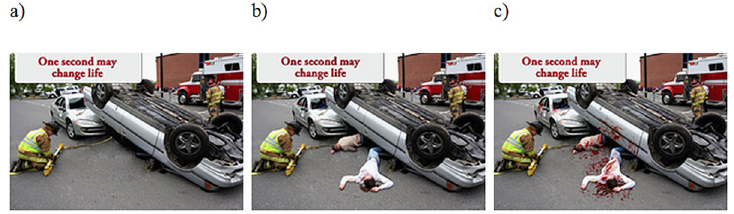
Fig 3. Stimuli used in the experiment: a) low intensity of negative emotions, b) medium intensity of negative emotions, c) high intensity of negative emotions. Reprinted from [95] under a CC BY license, with permission